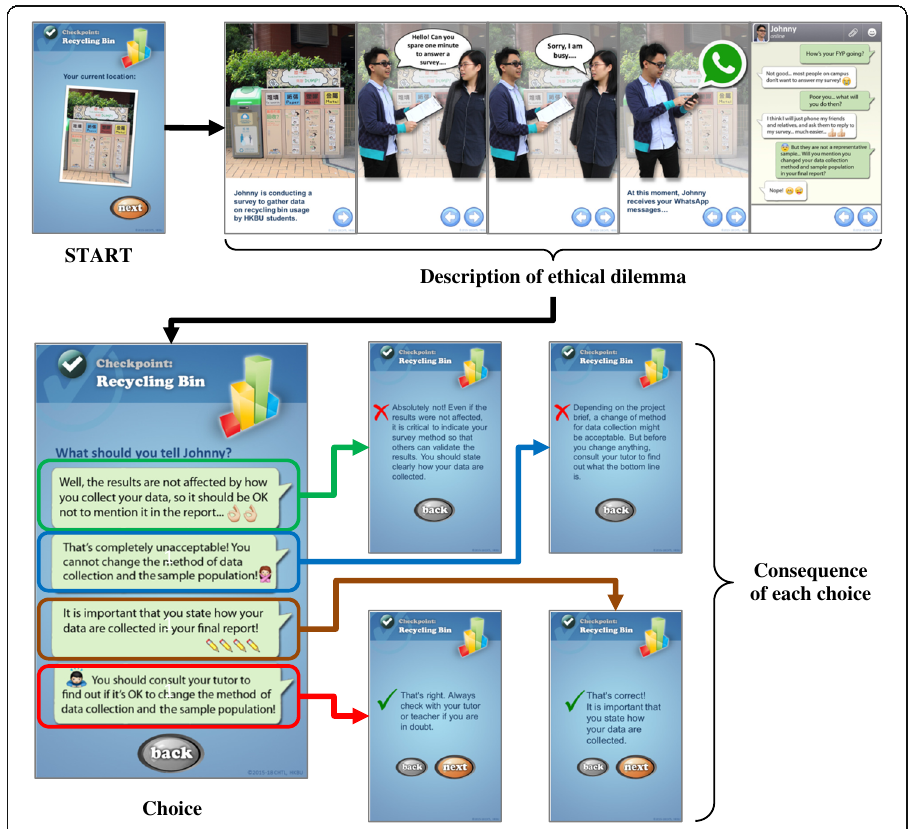
Fig. 1 An example checkpoint (data falsification) from